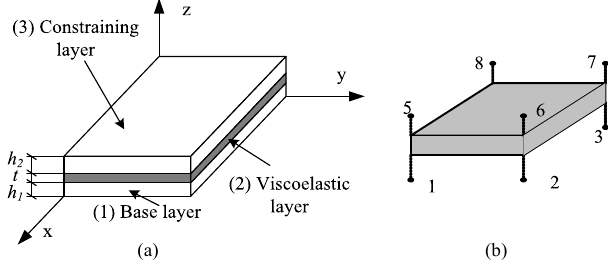
Fig. 1. Schematic of the model. (a) PCLD element; (b) interface element for viscoelastic